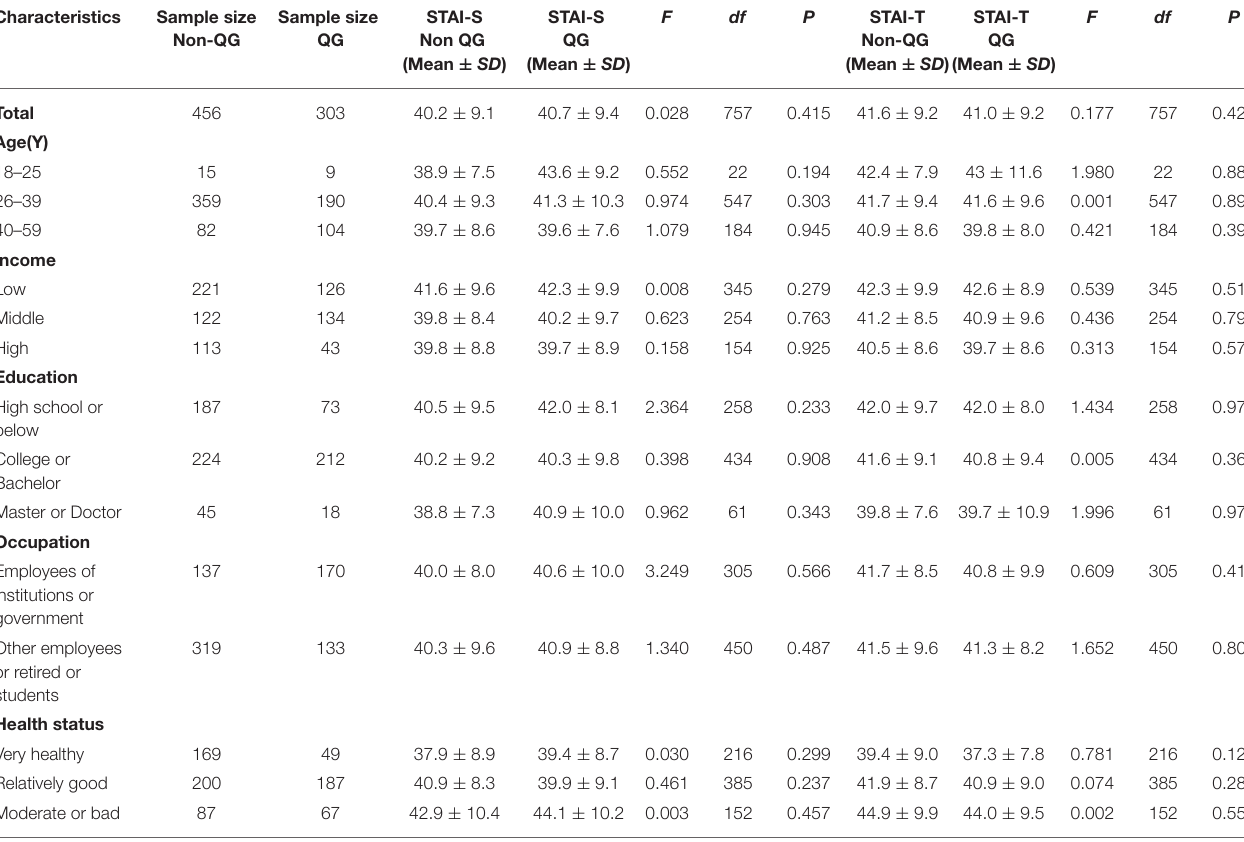
STAI-S, State-Trait Anxiety Inventory-State; STAI-T, State-Trait Anxiety Inventory-Trait; QG, quarantined group; Non-QG, non-quarantined group; Y, year. P-values < 0.05 are in bold typeface.